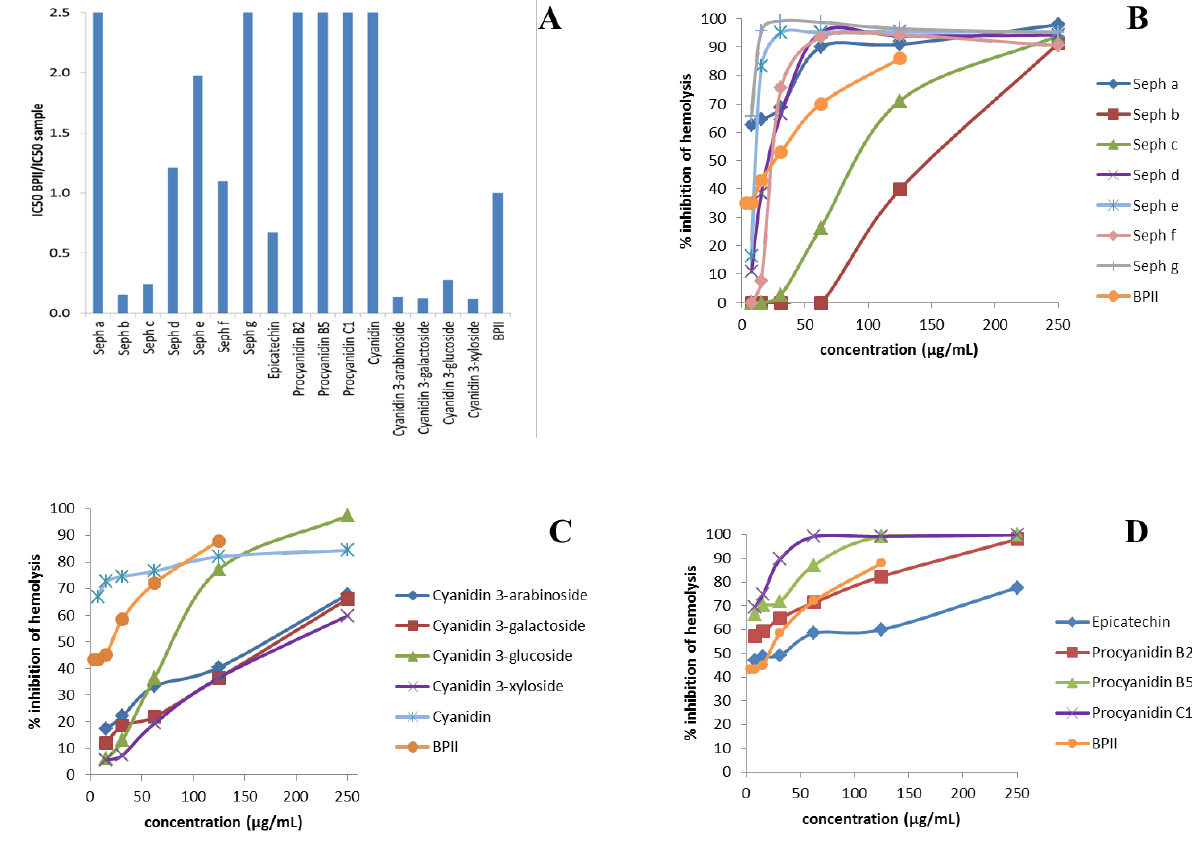
Figure 2. Complement-fixing activity of isolated fractions and phenolic compounds of aronia. ( A ) IC BPII/IC ratio for fractions and compounds tested. A high ratio means 50 50 high complement-fixing activity; ( B – D ) Inhibition of hemolysis by subfractions Seph a–g, by anthocyanidins and cyanidin aglycone, and by epicatechin (monomer) and dimeric and trimeric procyanidins. BPII was used as positive control in all these tests. The values represent the mean of duplicate samples (divergence between measurements less than